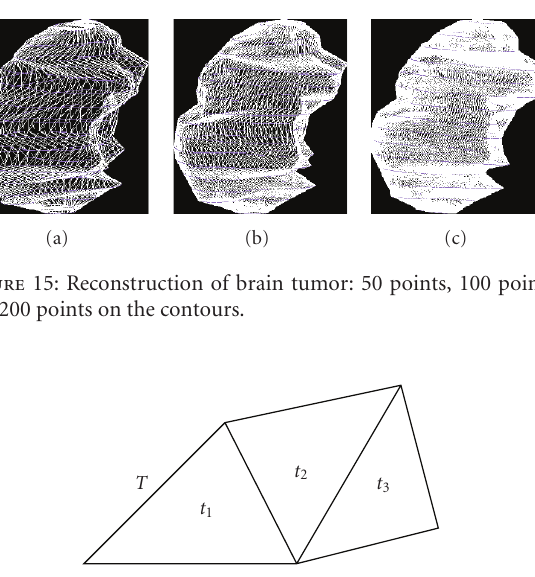
Figure 12: Triangulation T 0 between two contours (sections).